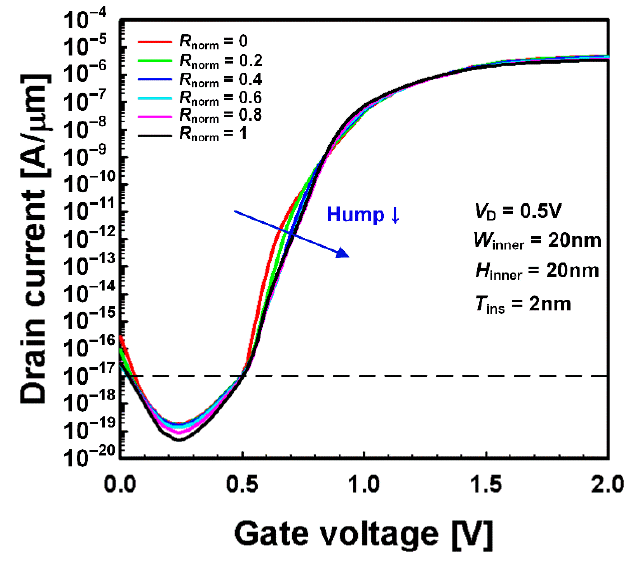
Figure 9. Transfer characteristics of gate-normal NWTFETs with the variation in the normalized radius of curvature of the corners ( R norm ) from 0 to 1. It is shown that the hump is suppressed with the increasing of R norm .